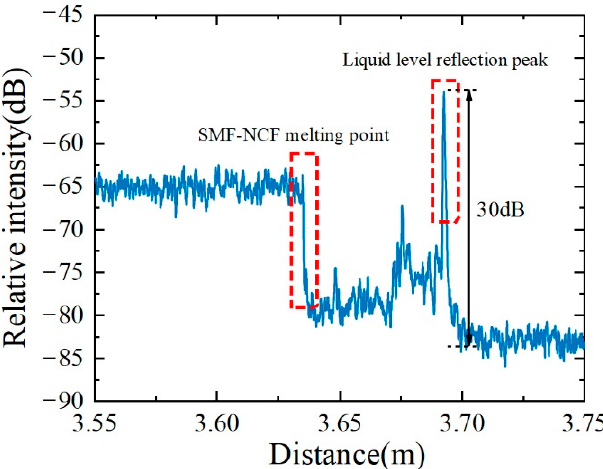
Figure 5. Typical reflection intensity of the liquid-level sensor in the distance domain.